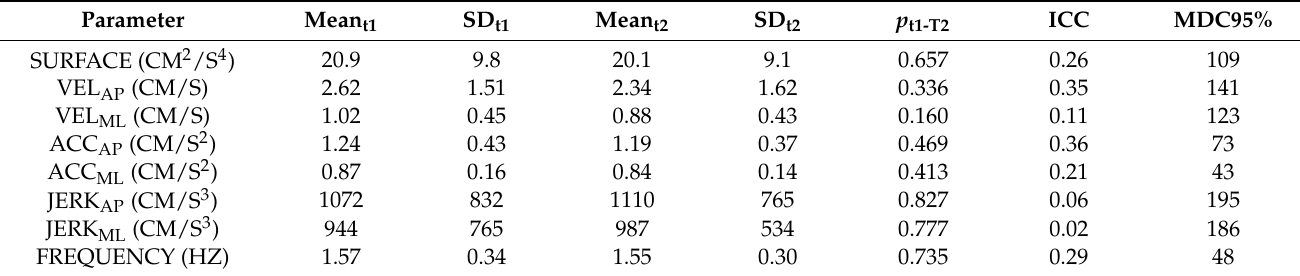
Table 1. Reliability and minimal detectable change: side-by-side stance on a hard surface ( n = 41). Parameter